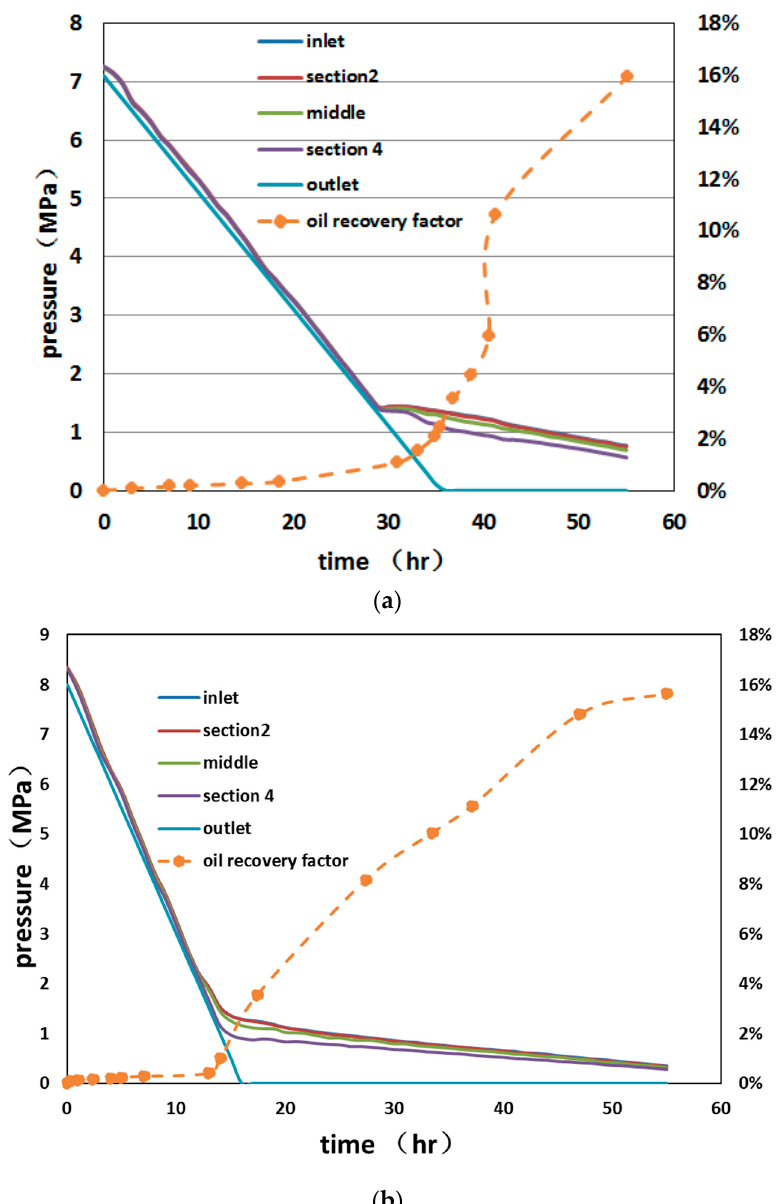
Figure 7. The relationship between pressure changes and the oil recovery of Experiments 2 and 3. ( a ) Experiment 2; ( b ) Experiment 3.